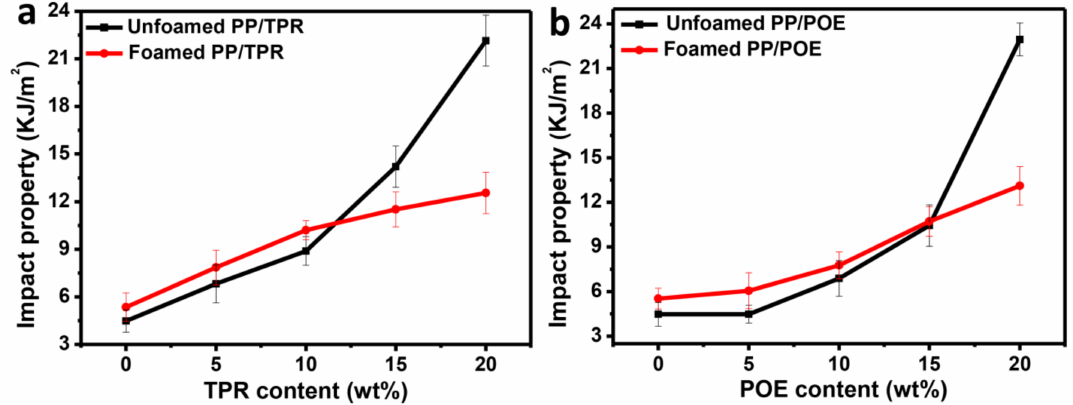
Figure 6. Influence of elastomers on the impact properties of PP composites: ( a ) PP/TPR, ( b )